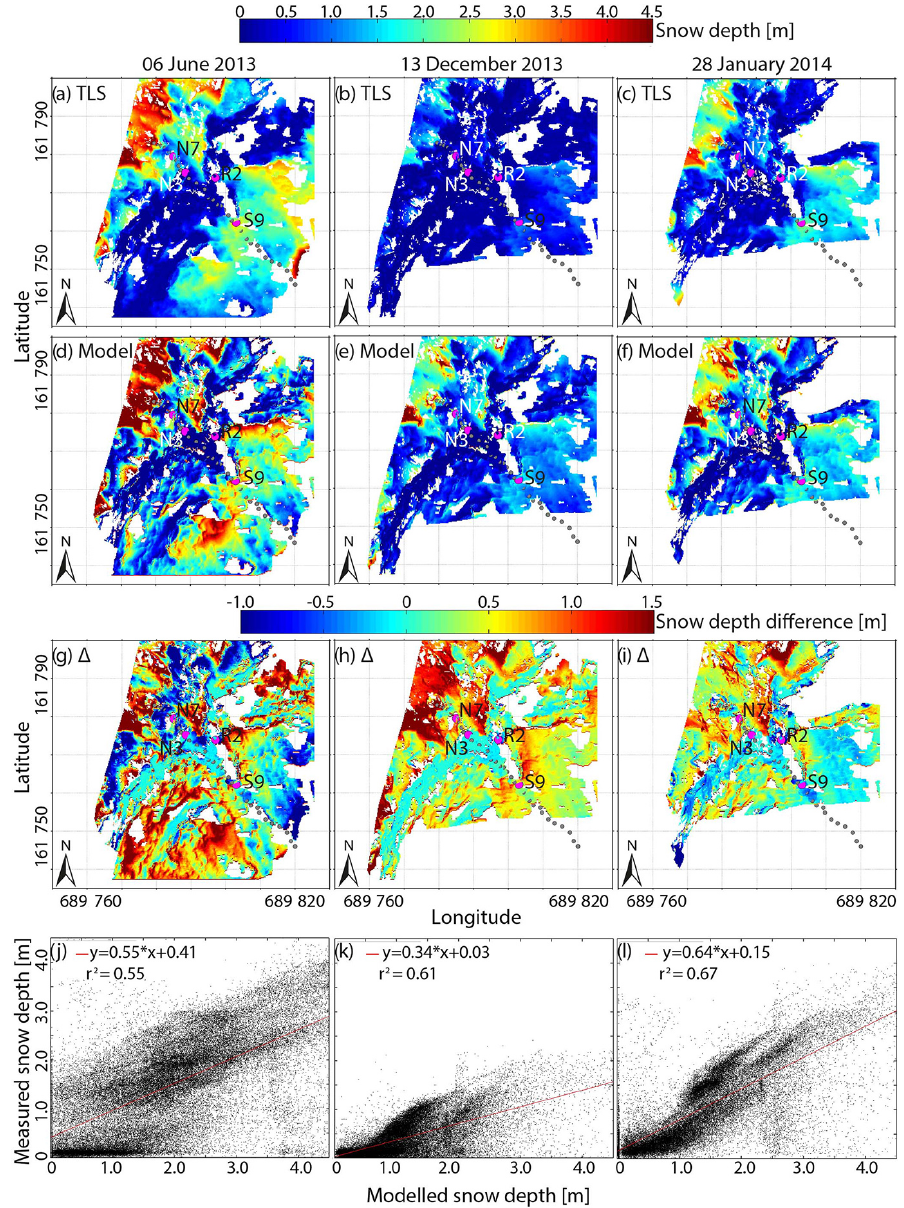
Figure 4. Snow depth distribution: (a–c) measured based on TLS; (d–f) modelled at the same dates as the TLS campaigns; (g–i) differences (cid:49) between modelled and measured snow depth; (j–l) measured snow depths as function of modelled snow depths. Grey dots indicate the locations of NSRT loggers and selected ones are highlighted in pink and labelled.